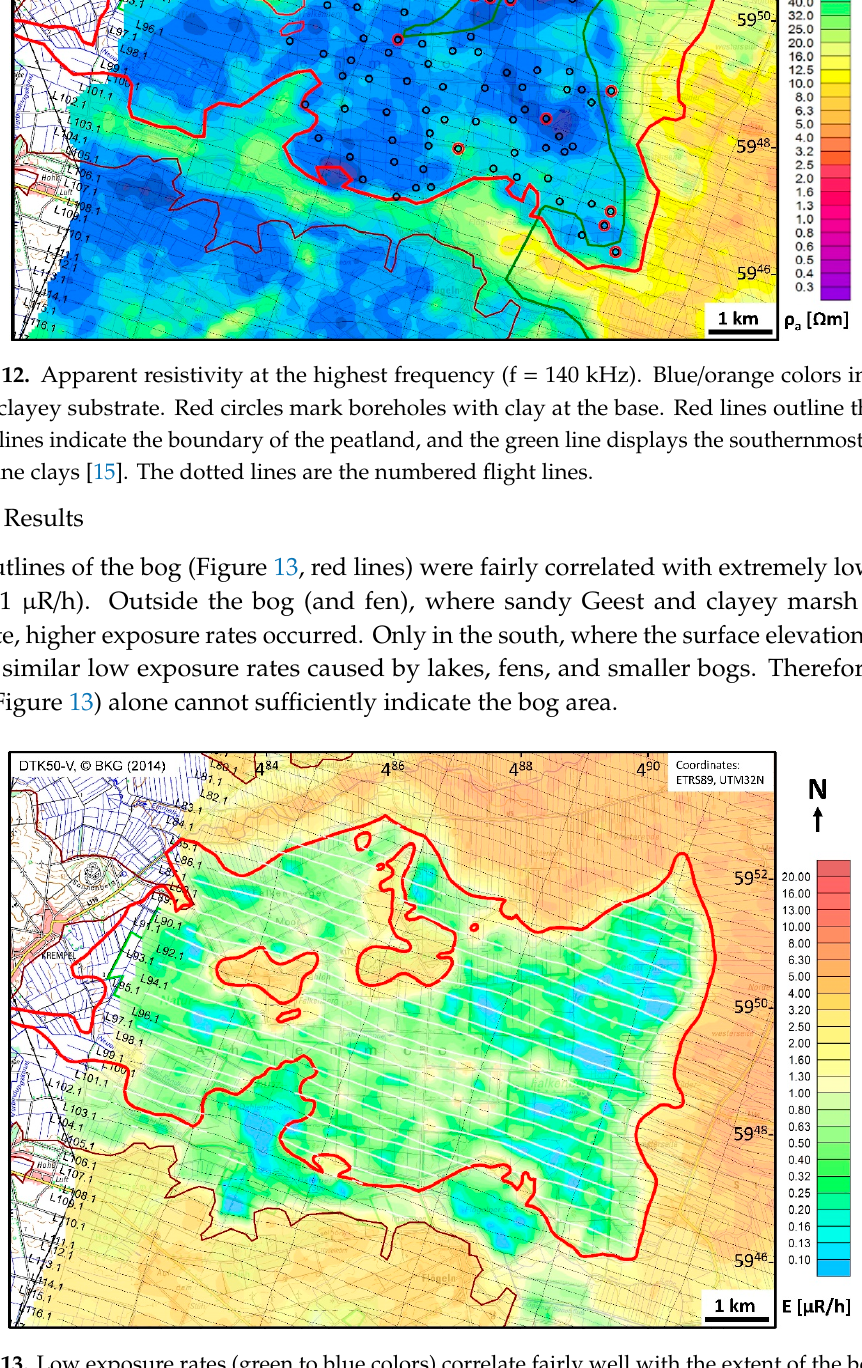
Figure 13. Low exposure rates (green to blue colors) correlate fairly well with the extent of the bog (red lines), except in the south, where lakes, fens, and smaller bogs exist within the area of the peatland (brown lines) [15]. The white lines on the black flight lines represent the peat indicator derived from areas of low radiation and higher elevation. areas of low radiation and higher